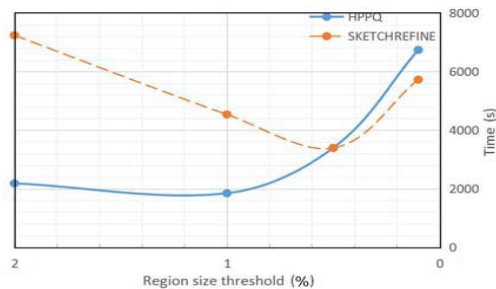
Fig. 12 Impact of threshold on synthetic dataset.